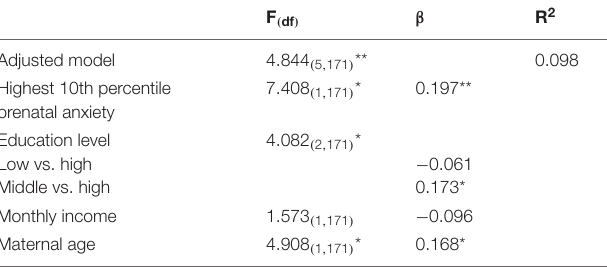
TABLE 5 | ANCOVA for the unpredictability of maternal sensory signals ( n =